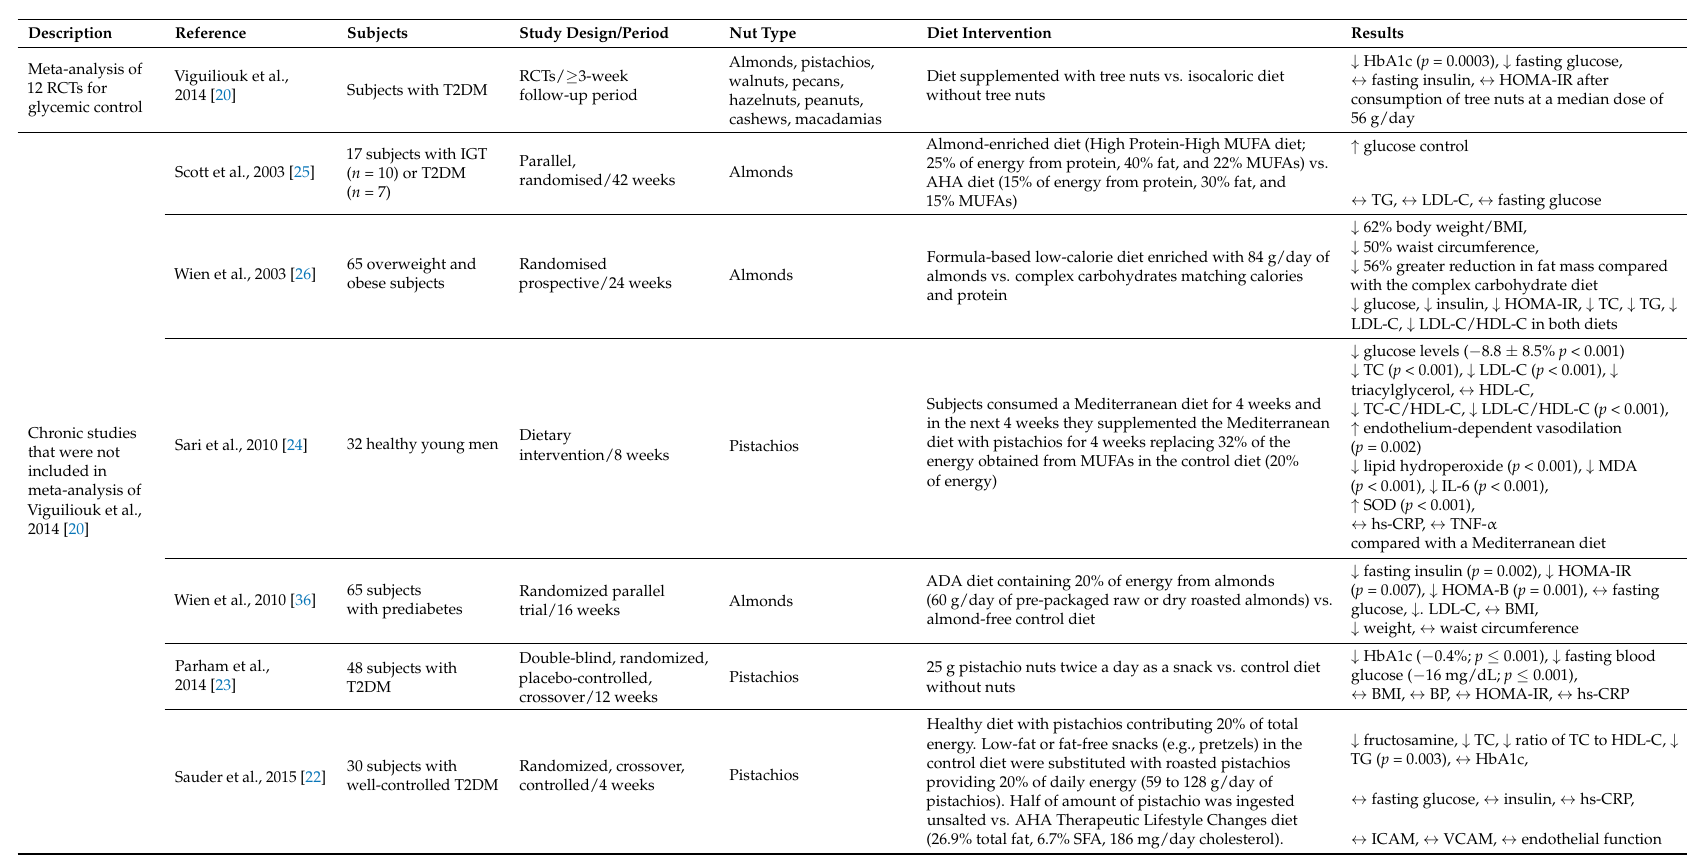
Table 2. Summary of clinical trials examining the effect of nut consumption on glycemic